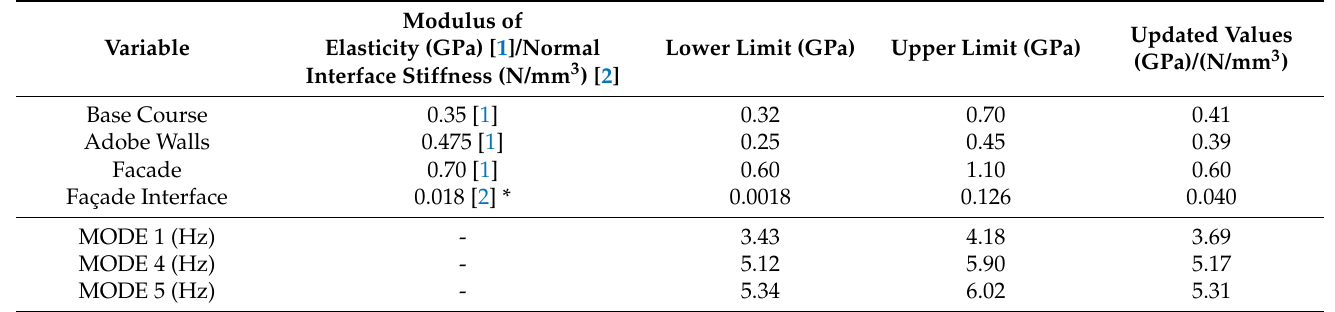
Table 6. Upper and lower limit values for calibration for MODEL_2, with the corresponding frequen- cies, for the selected modes.